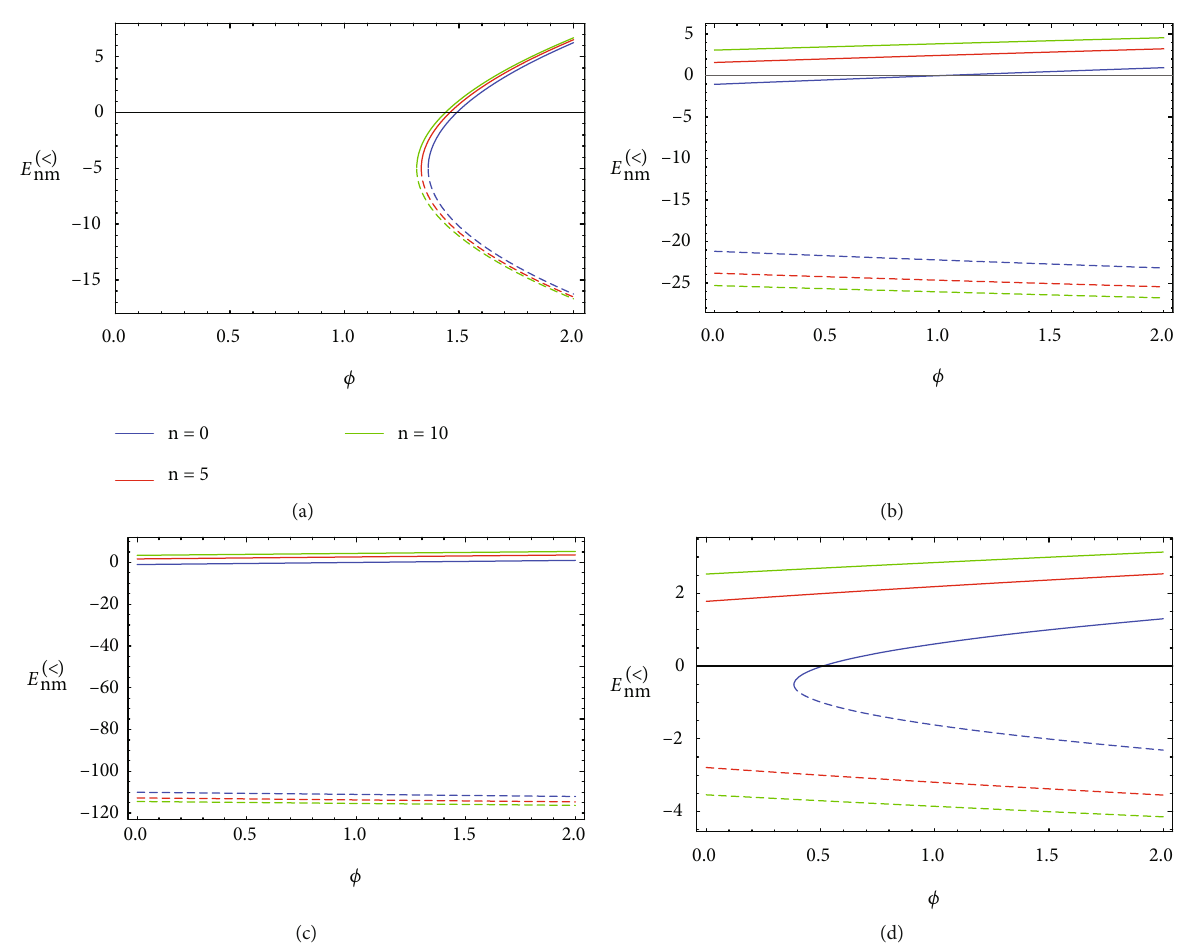
Figure 2: Sketch of the energy (Equation (71)) as a function of ϕ for m = 1 . In panel (a), for B = 1 : 0 , a = 0 : 05 and α = 0 : 01 . In panel (b), B = 10 : 0 , a = 1 : 0 and α = 0 : 9 . In panel (c), B = 50 : 0 , a = 1 : 0 and α = 0 : 9 . In panel (d), B = 1 : 0 , a = 0 : 5 and α = 0 : 99 . For a particular choice of parameters, ranges of ϕ where the energy of a state with a given n is forbidden